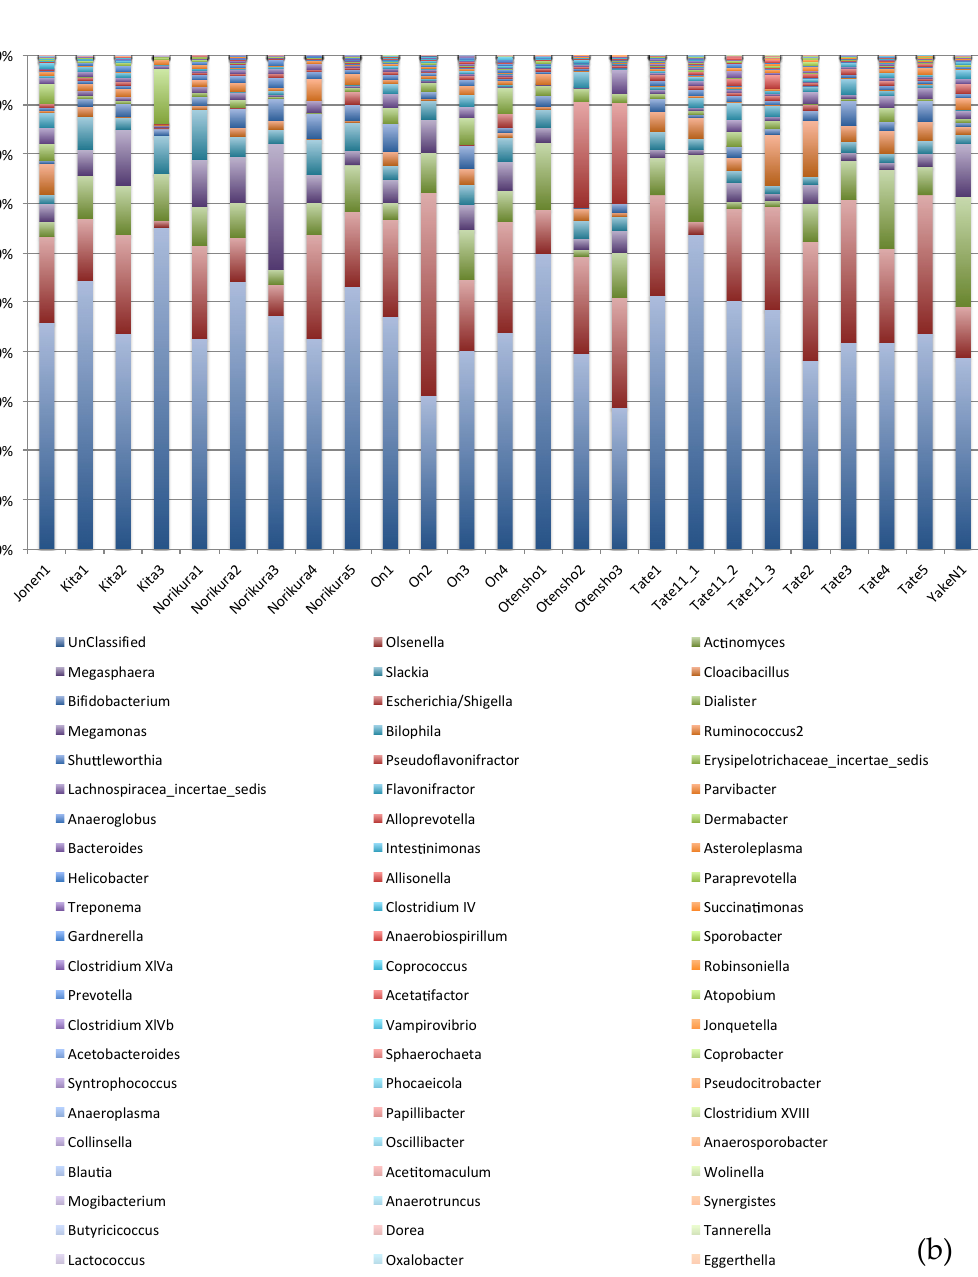
Figure 3. ( a ) Community structure at the family level of cecal microbiota of wild Japanese rock ptarmigans at different locations in Japanese mountains. ( b ) Community structure at the genus level of cecal microbiota of wild Japanese rock ptarmigans at different locations in Japanese mountains.